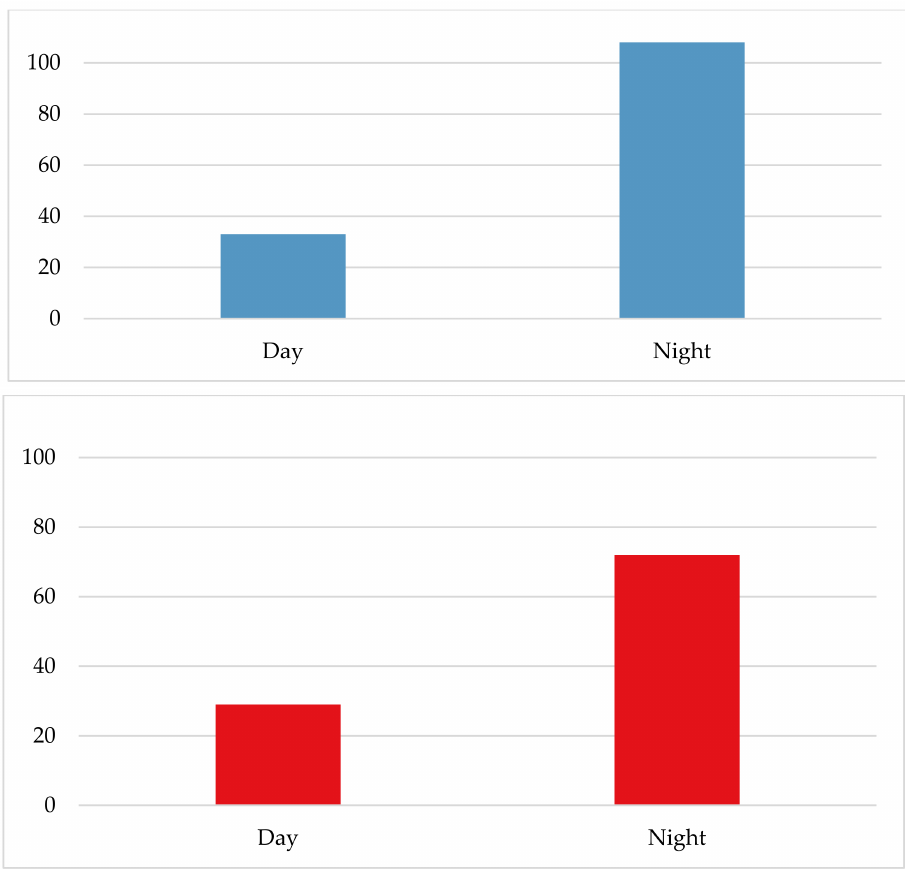
Figure A4. Reports of gunshots pre-COVID-19 (blue) and during COVID-19 (red) in Mexico City for different times of the day. Source: Authors’ own with office